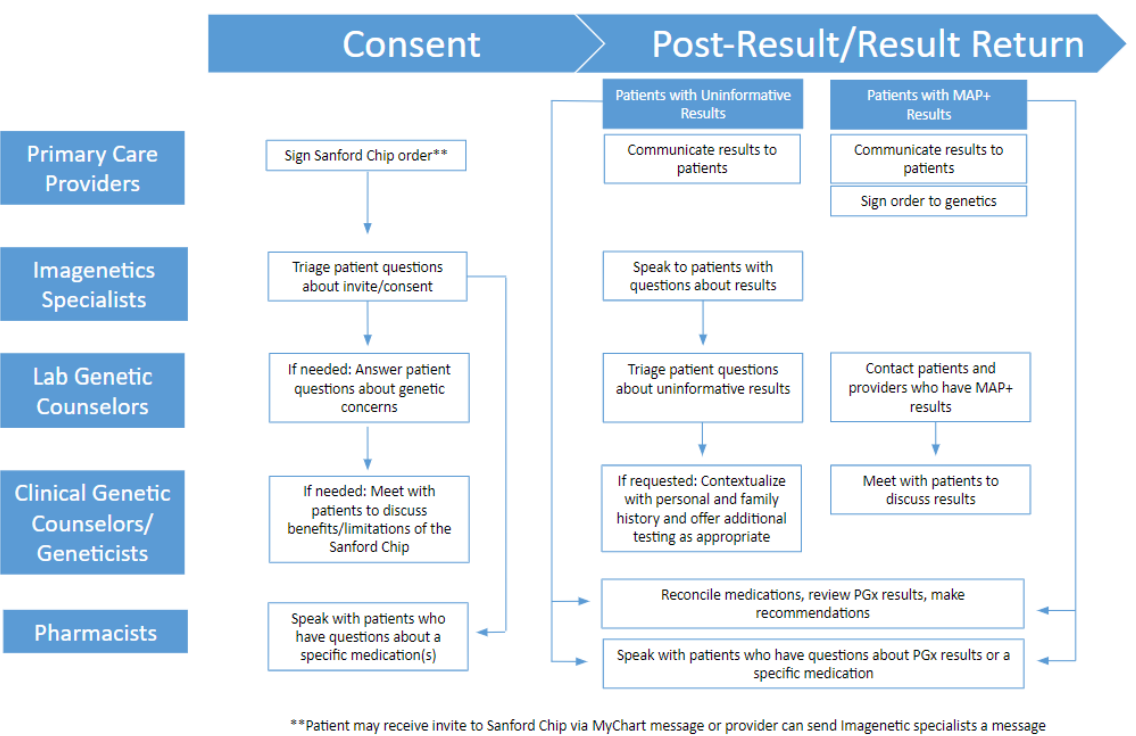
Figure 1. Workflow for the genetic screen through the precision medicine program. Workflow showcases the role each member of the clinical team plays in the process of offering the Sanford Chip genetic screen and return of results.